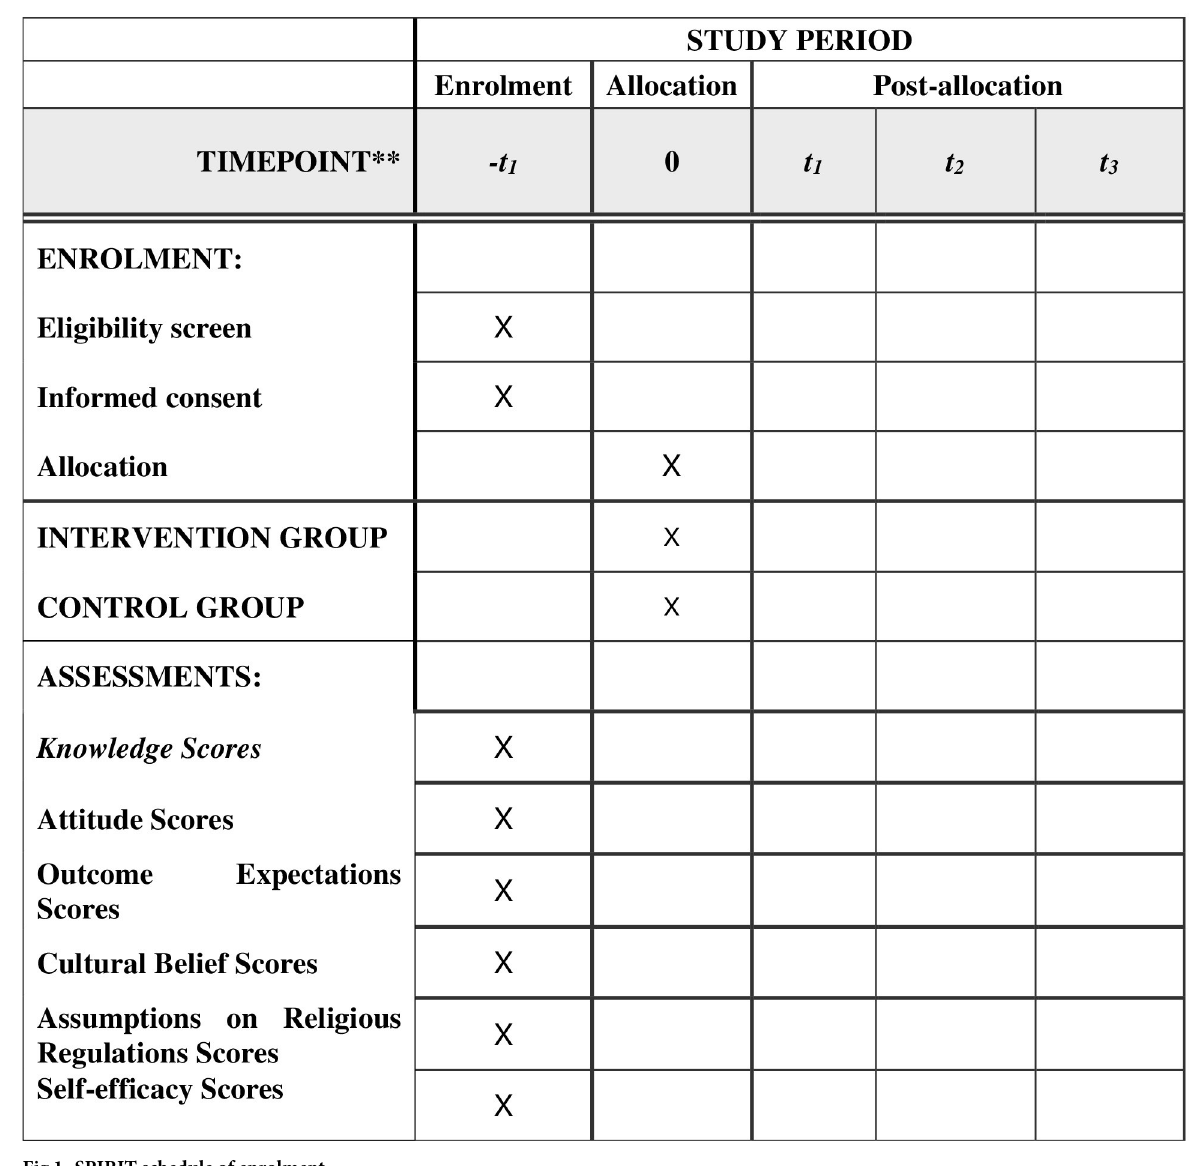
Fig 1. SPIRIT schedule of